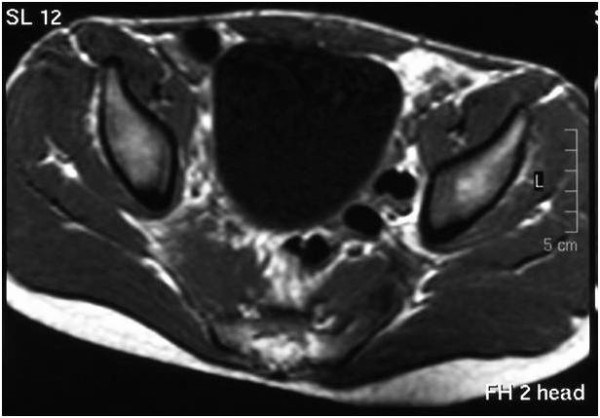
Axial spin-echo T1-weighted image; MRI scan taken at the time of antibiotic treatment initiation. The right piriformis muscle is enlarged. The surrounding fat planes are intact.